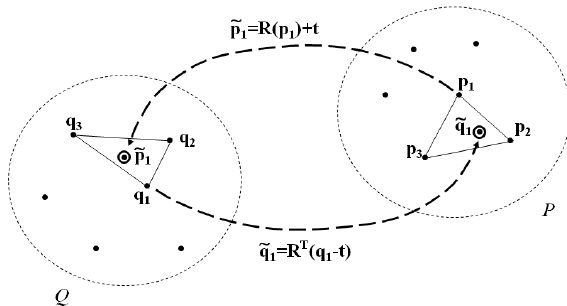
Figure 1: Point-to-Plane Correspondence. The planar element q q for transformed point p˜ is q ≡ [ q ] with local surface 1 e 1, 2, 3 normal nˆ q , and similarly for transformed point q˜ p p p ≡ [ p ] with local surface normal nˆ p e 1, 2, 3